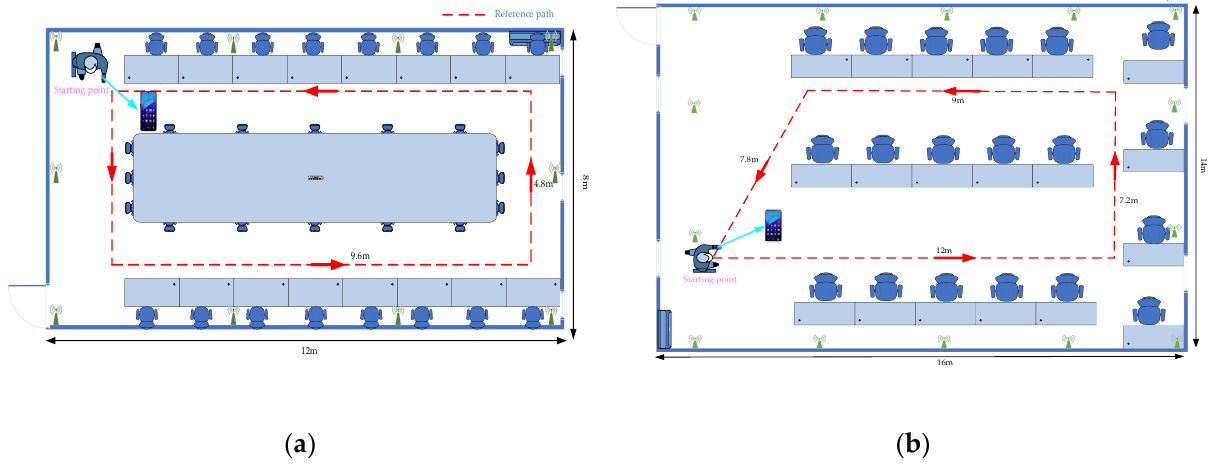
Figure 6. Trial experimental site floor plans. ( a ) Scenario 1. ( b ) Scenario 2.